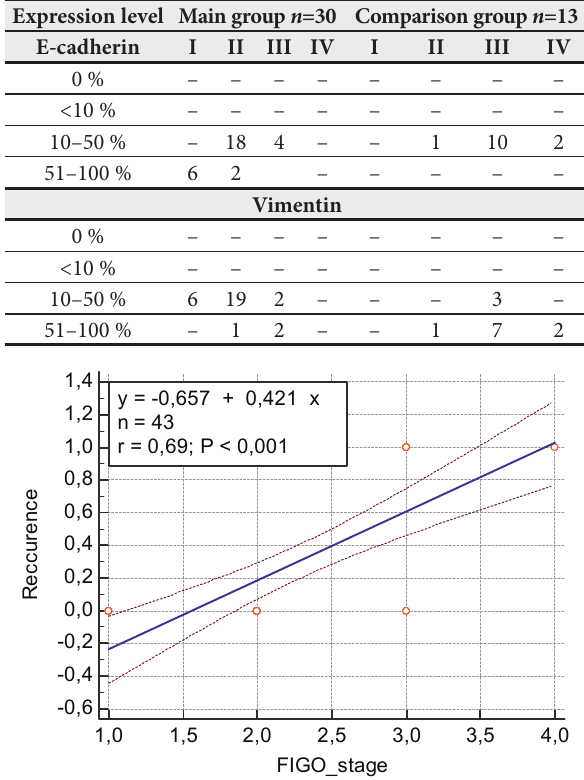
Fig. 1. Graphical representation of the relationship between FIGO stage and LGSC